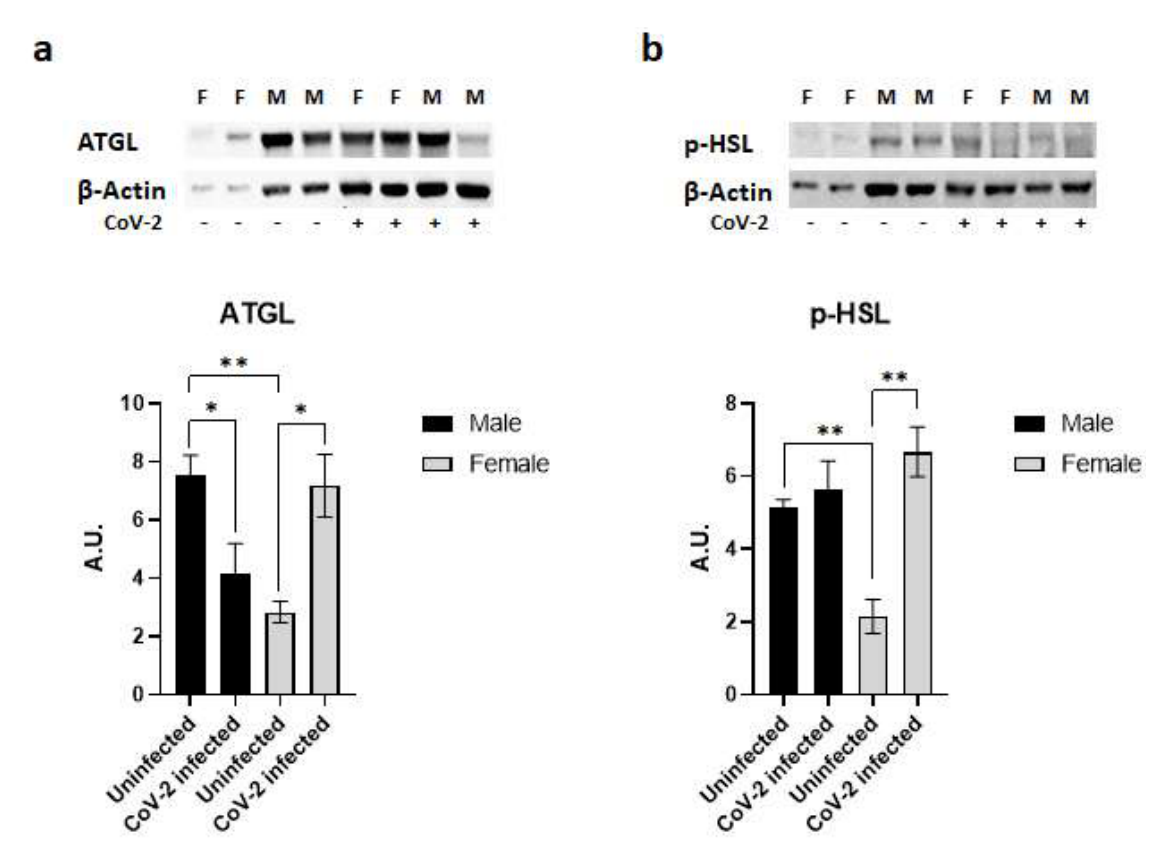
Figure 4. SARS-CoV-2 infection activates lipases in the adipose tissue of female hACE2 mice. Western blot images of ( a ) ATGL and ( b ) p-HSL. β -actin was used as loading control. Fold changes in the protein levels were normalized to β -actin expression and are shown as bar graphs. The error bars represent standard error of the mean. * p < 0.05 and ** p < 0.01 compared to uninfected mice ( n = 4/sex/group) (M, male; F, female).